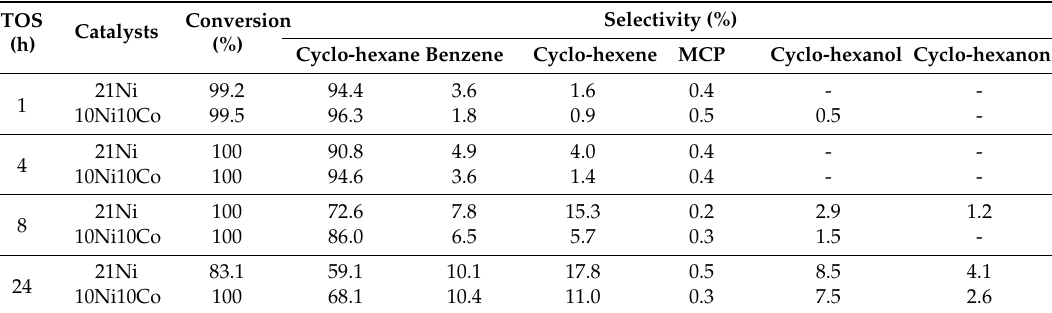
Table 7. Product distribution over HZSM-5-supported